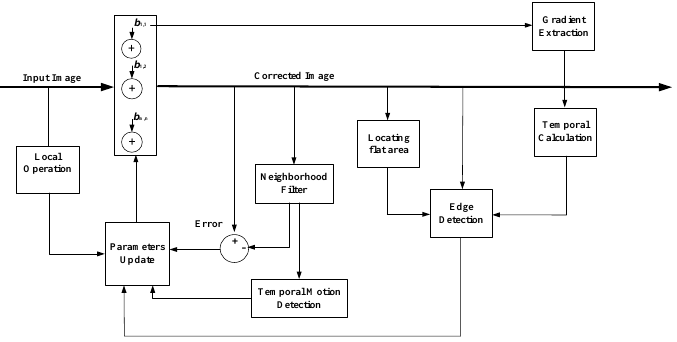
Figure 4. Scheme of proposed adaptive spatial and temporal deghosting–least mean square nonuniformity correction (AST–LMS NUC)